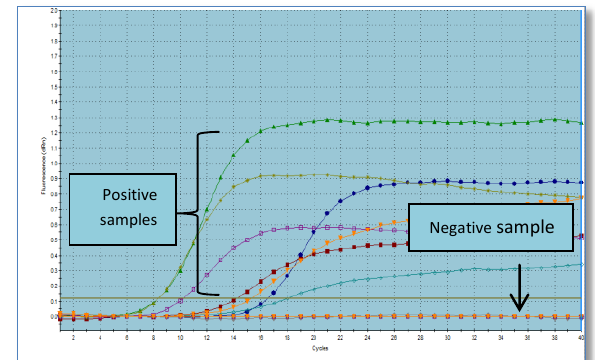
Figure, 1: Real-Time PCR Amplification Plots for MOMP Gene in C. trachomatis that display a positive and negative DNA samples by using syber green 1 RT-PCR amplification.